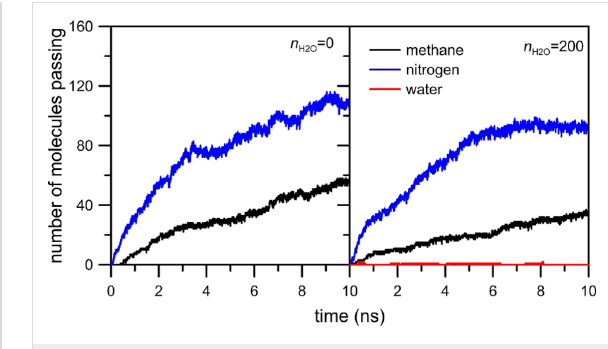
Figure 5: The influence of water on the number of methane and nitrogen molecules passing through an NHH nanopore.